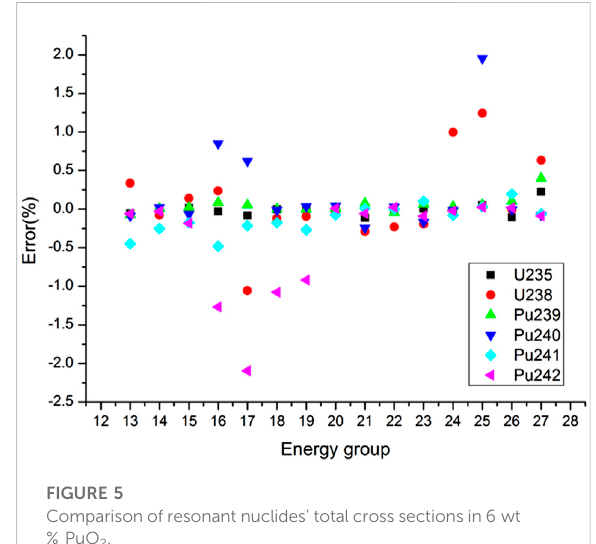
FIGURE 5 Comparison of resonant nuclides ’ total cross sections in 6 wt % PuO 2